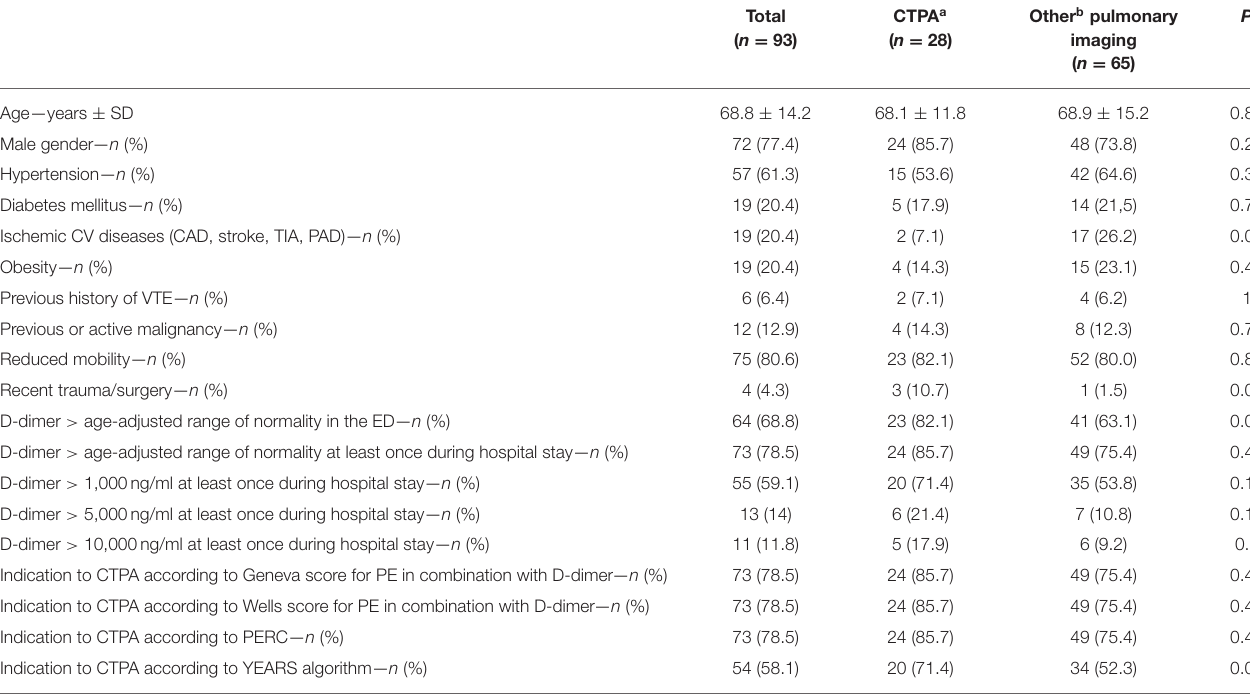
TABLE 1 | Characteristics of the patients and theoretical indication to undergo CTPA according to Geneva score, Wells score, PERC, and YEARS